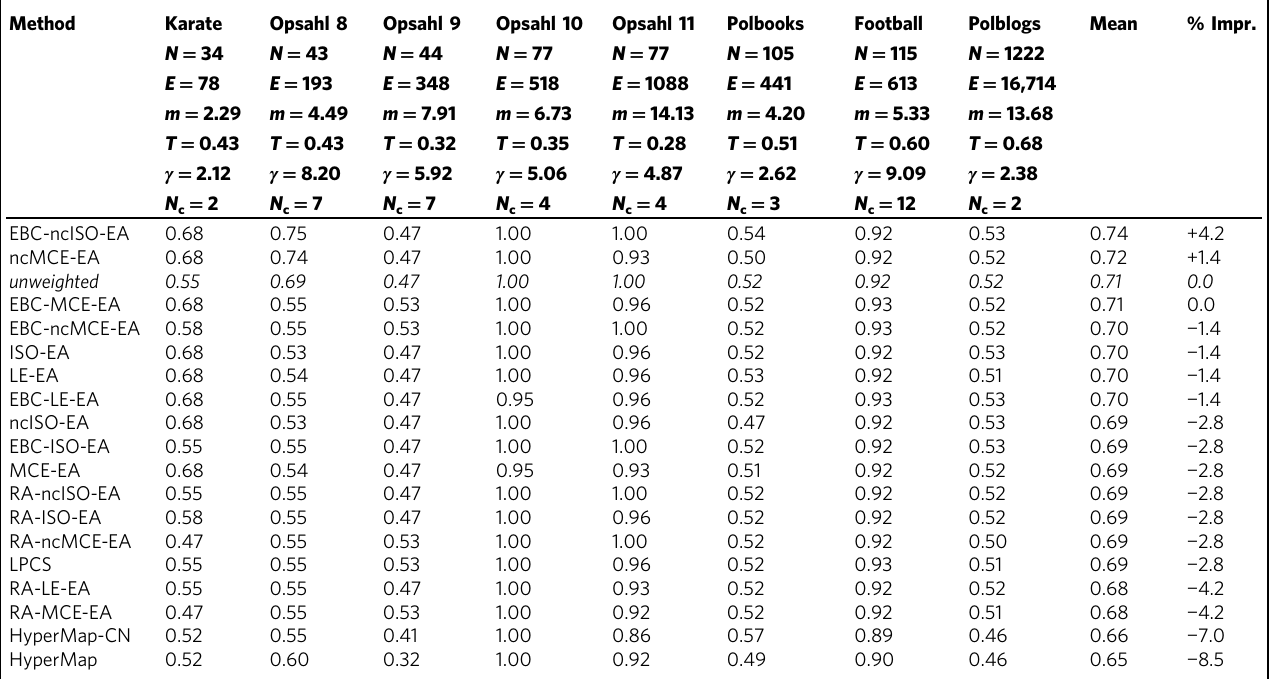
Table 2 Community detection on real networks with Infomap algorithm